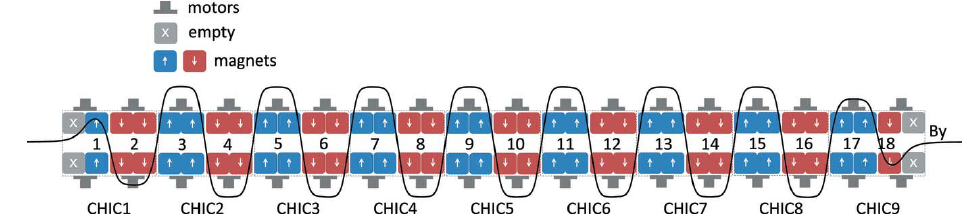
Figure 1 Functional view of the modulator with its nine CHIC modules with 18 independently movable magnetic poles. The black solid line is an example of the measured magnetic field profile, By .